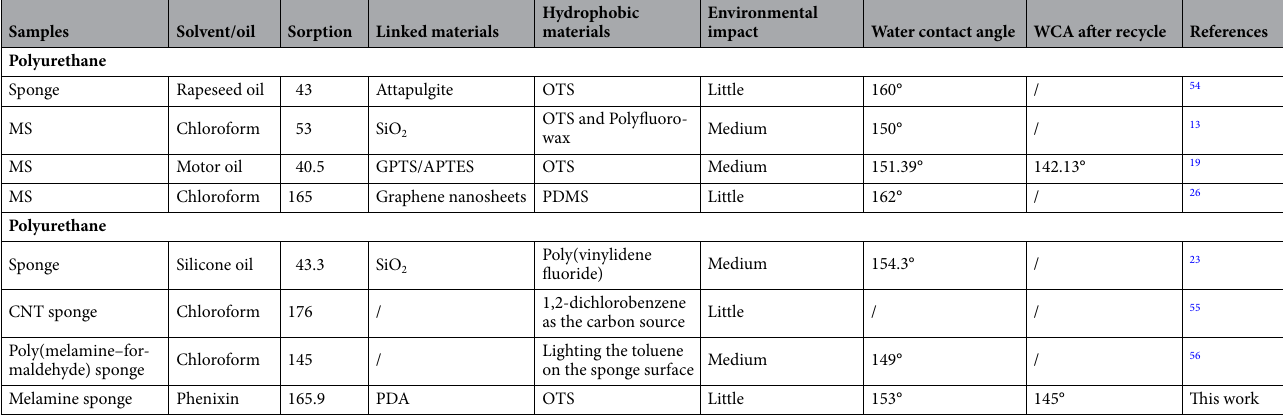
Table 2. Comparison of various superhydrophobic sponges. The “/” represents the data were not given in the references.